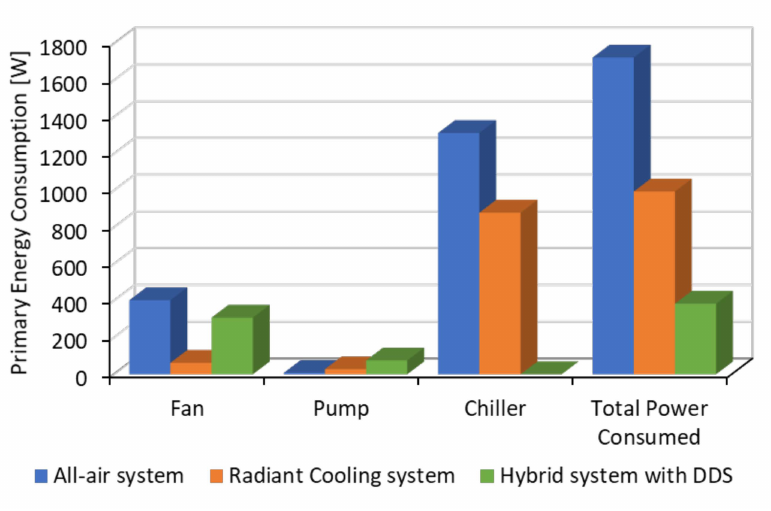
Figure 8. Comparison of primary energy